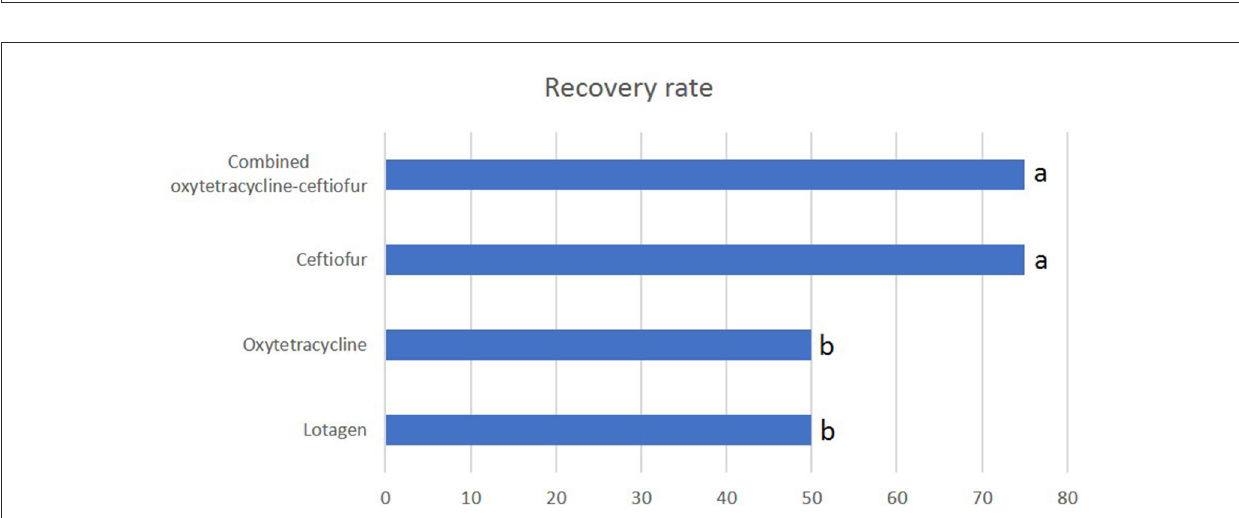
FIGURE2 The pregnancy rate in different protocols used for the treatment of endometritis in dromedary camels. The pregnancy rate was calculated by dividing the number of camels diagnosed as pregnant 28 days after mating by the total number of camels mated. Columns with different letters indicate a significant difference ( P <